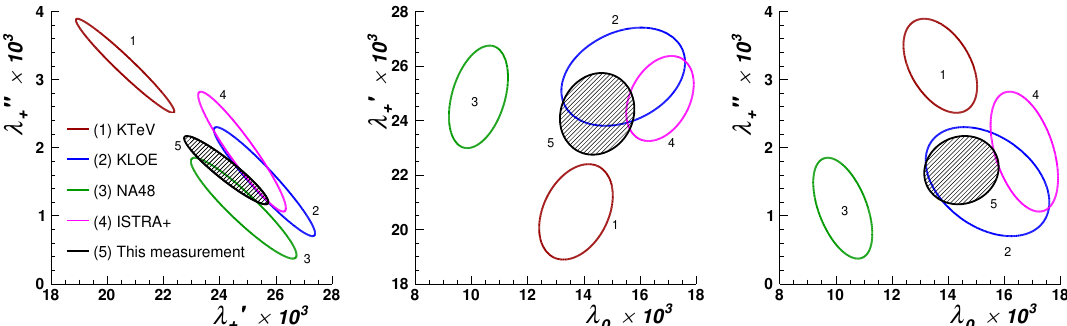
Figure 9 . One sigma (39.4% CL) contours for the parameters of the Taylor expansion obtained from the joint analysis together with the combinations of K e 3 and K (cid:22) 3 measurements by the KTeV [16], KLOE [17, 18], NA48 [19, 20], and ISTRA+ [21, 22] Collaborations provided by